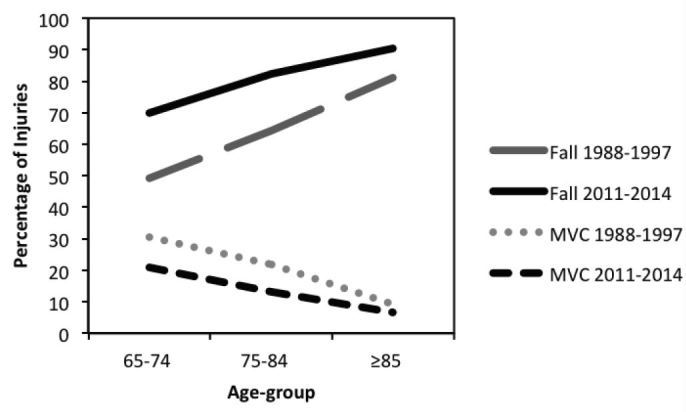
Change over time in injury mechanism from Richmond et al. study (using the same Pennsylvania trauma data source from 1988–1997) to current study (2011–2014).MVC, motor vehicle collision.